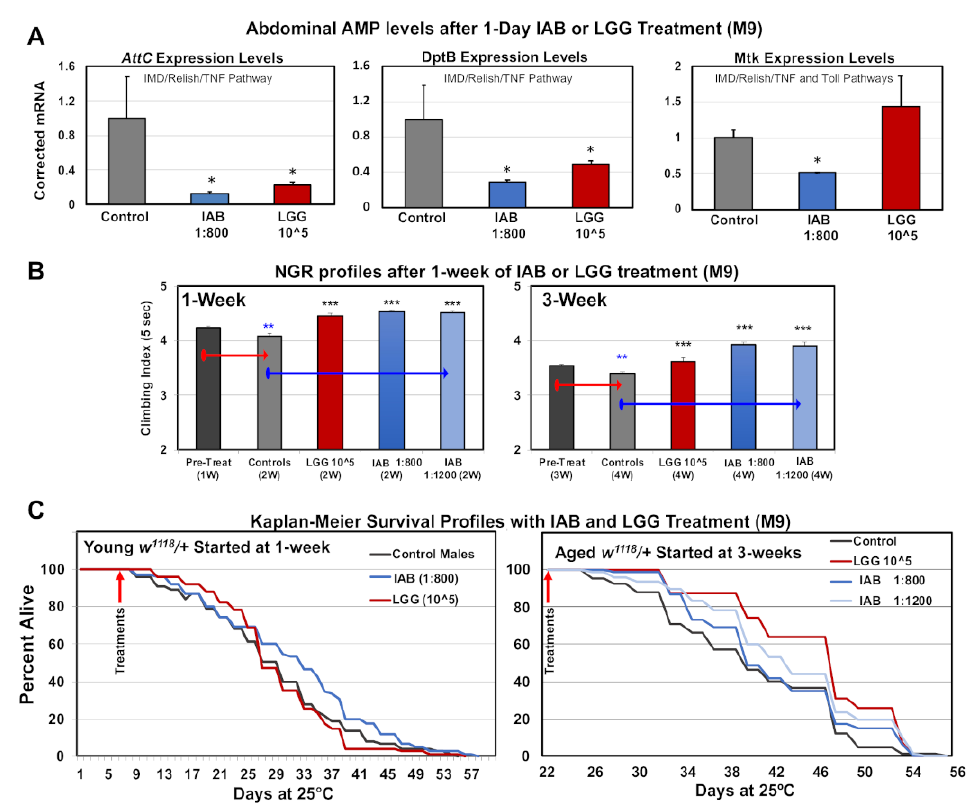
Figure 5. Immune and age-related responses to IAB and Lactobacillus rhamnosus (LGG) treatments. ( A ) Anti-microbial peptide (AMP) expression profiles in fly abdominal tissues following 24 h of IAB (1:800) or LGG (10 5 CFU) treatment. ( B ) NGR of young (one-week-old) or middle-aged (three- week-old) flies after one week of control (M-9), LGG (10 5 CFUs), IAB 1:800, or IAB 1:1200 treatment. ( C ) The Kaplan–Meier Survival profiles of young or middle-aged flies with control (M-9), IAB 1:800, IAB 1:1200, or LGG (10 5 CFUs) treatment (* p -values < 0.5, ** p -values < 0.01, *** p -values < 0.001). See Supplementary Table S4A,B for fly numbers (n) and additional